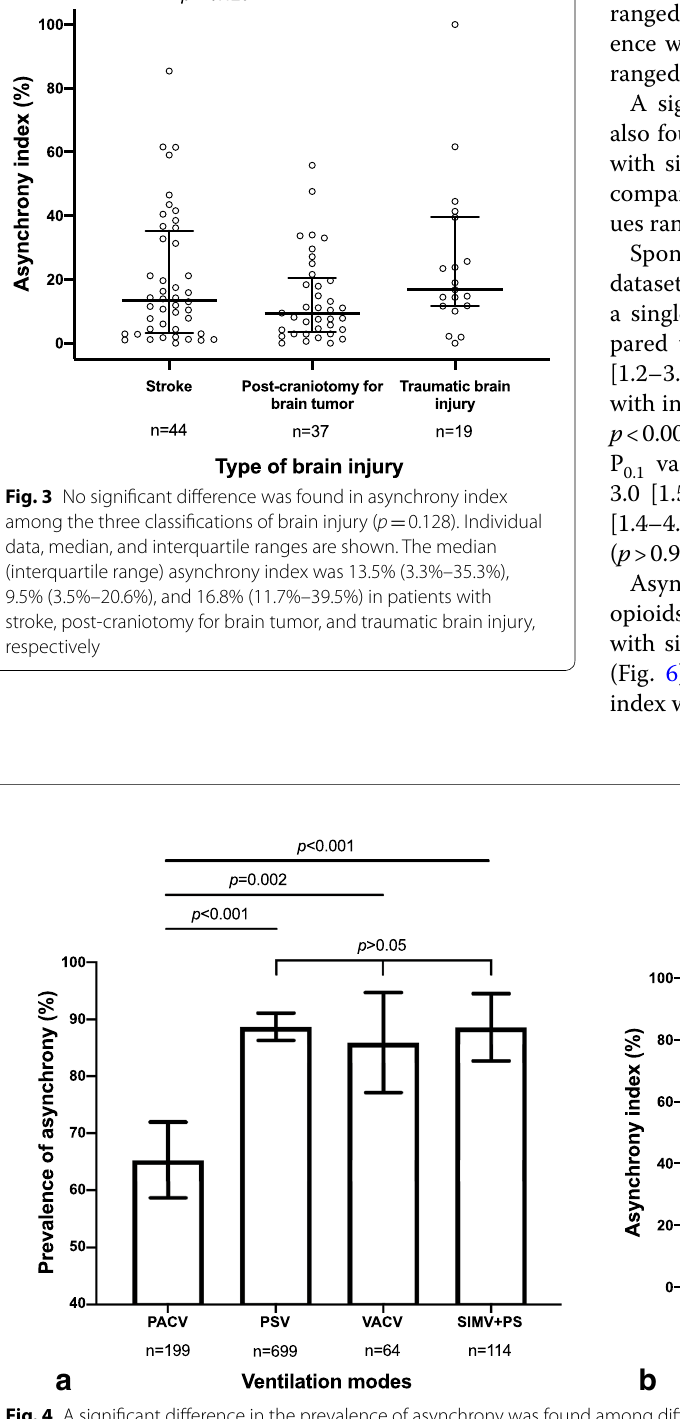
Fig. 4 A significant difference in the prevalence of asynchrony was found among different ventilatory modes ( p < 0.001, panel a ). Percentage and 95% confidence interval are shown. The prevalence of asynchrony during pressure assist/control ventilation (PACV) was significantly lower than those during pressure support ventilation (PSV), volume assist/control ventilation (VACV), and pressure‑preset synchronized intermittent mandatory ventilation plus pressure support (SIMV PS). No significant difference was found among the PSV, VACV, and SIMV PS (panel b ). Individual data, + + median, and interquartile ranges are shown. A significant difference in asynchrony index was also found among different ventilatory modes ( p < 0.001, panel b ). Asynchrony indexes during PACV and PSV were significantly lower than those during VACV and SIMV +